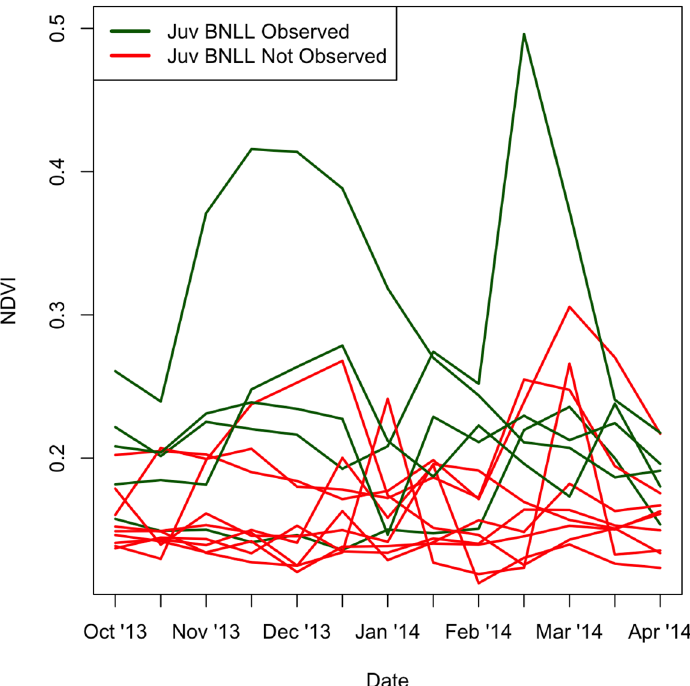
Fig 3. Time series of NDVI values at 14 sites included in this study (16-day temporal resolution). NDVI was extracted from 250-m resolution MODIS grid cells using a 500-m neighborhood around the centroid of BNLL neonate